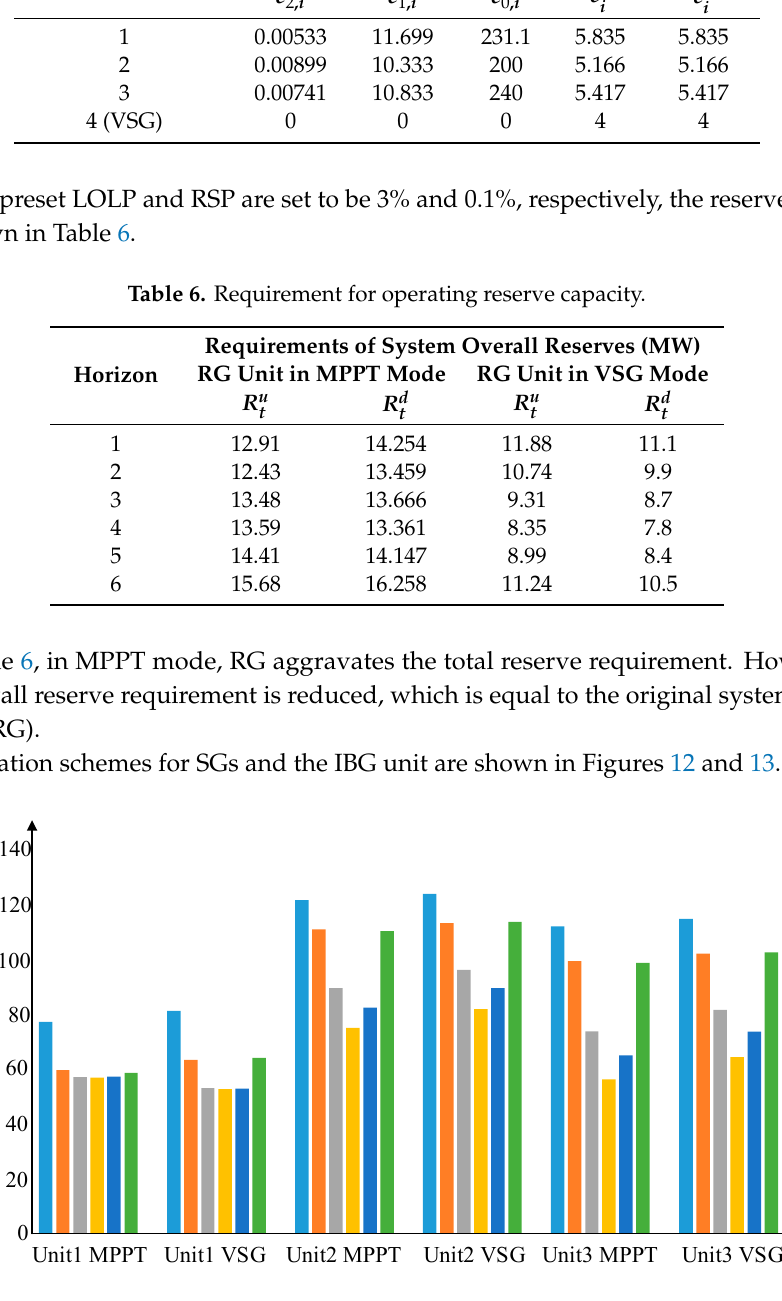
Table 5. Generation cost coefficients.